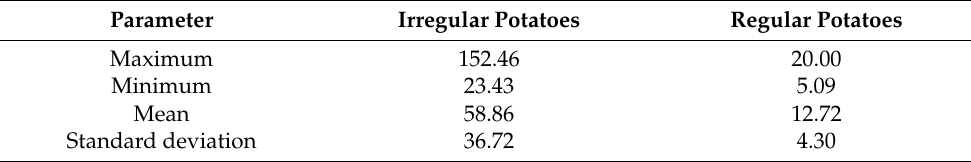
Figure 12. Hausdorff distance values for irregular and regular potatoes. Table 2. Maximum, minimum, mean, and standard deviation of Hausdorff distance.